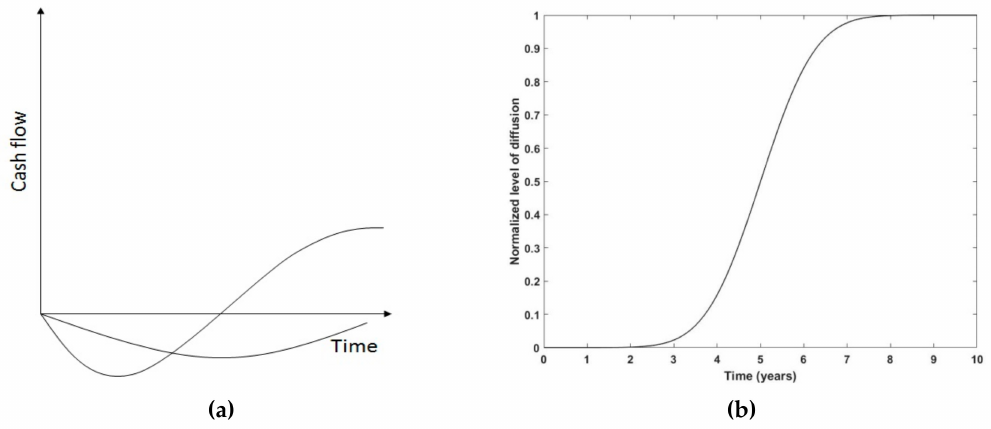
Figure 1. ( a ) Cash flow of modeling and simulation (M&S) as the time-history of profit, ( b ) A theoretical Rogers curve for di ff usion / penetration of